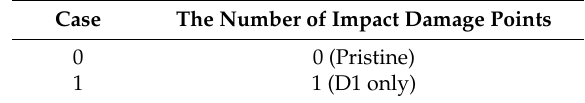
Table 2. The pristine and damaged sample cases considered for